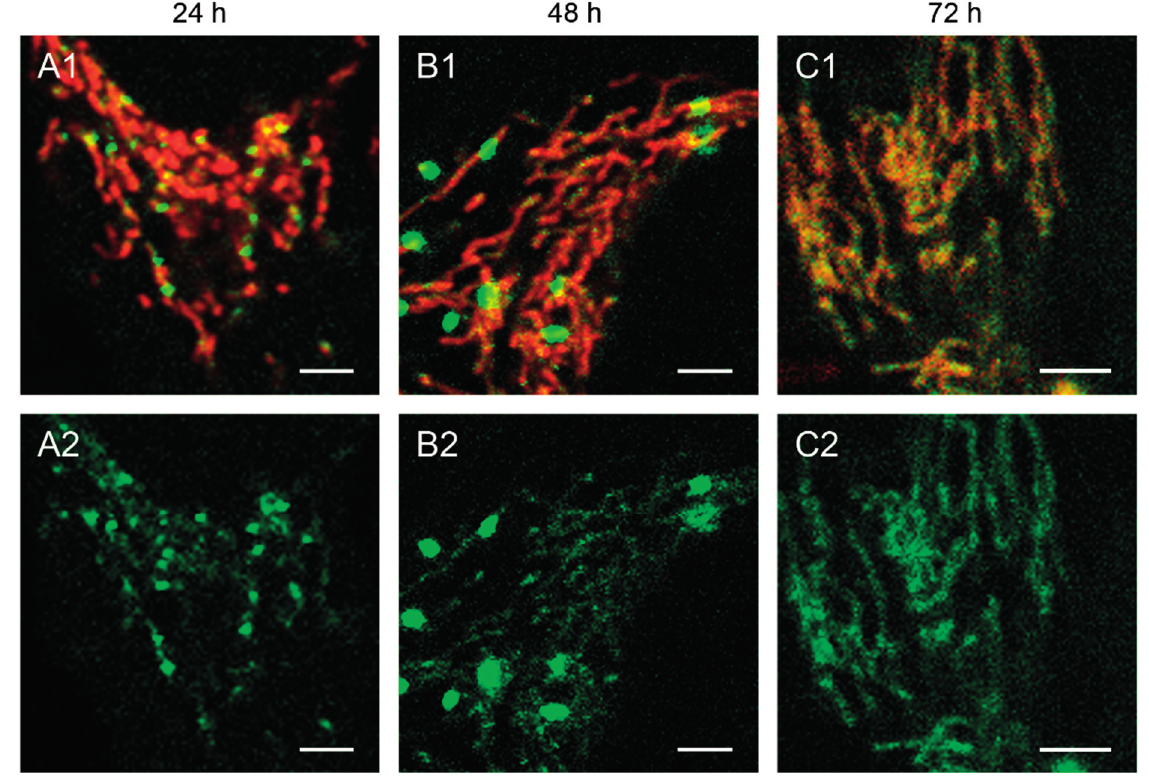
Figure 2. Detailed images of HEp-2 cells transfected with circular depletion system. Cells were transfected with the circular depletion system (pMEE-con with EGFP, green color, bottom panels A2 – C2 ) and analyzed by confocal laser scanning microscopy at intervals of 24 h post-transfection. The mitochondrial network was stained with MitoTracker ® Red CMXRos (red color, overlay top panels A1 – C1 ). The punctate appearance of the fusion protein EGFP-EcoRI merged into an evenly stained mitochondrial network 72 h post-transfection compared to 24 h/48 h, indicating that the interacting partner (mtDNA) of the restriction enzyme disappeared. Calibration marks correspond to 2.5